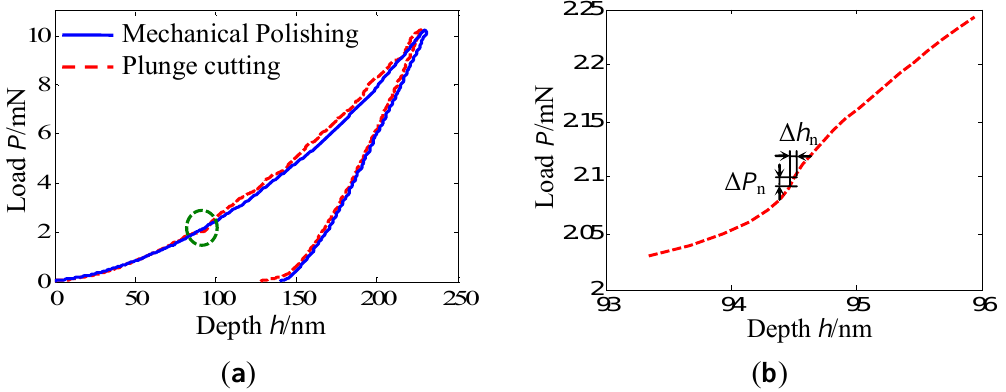
Figure 2. ( a ) Typical load-depth ( P - h ) curves of the Zr-based bulk metallic glass under different sample preparation methods; ( b ) Partial enlarged view of ( a ) highlighting details of the serrated